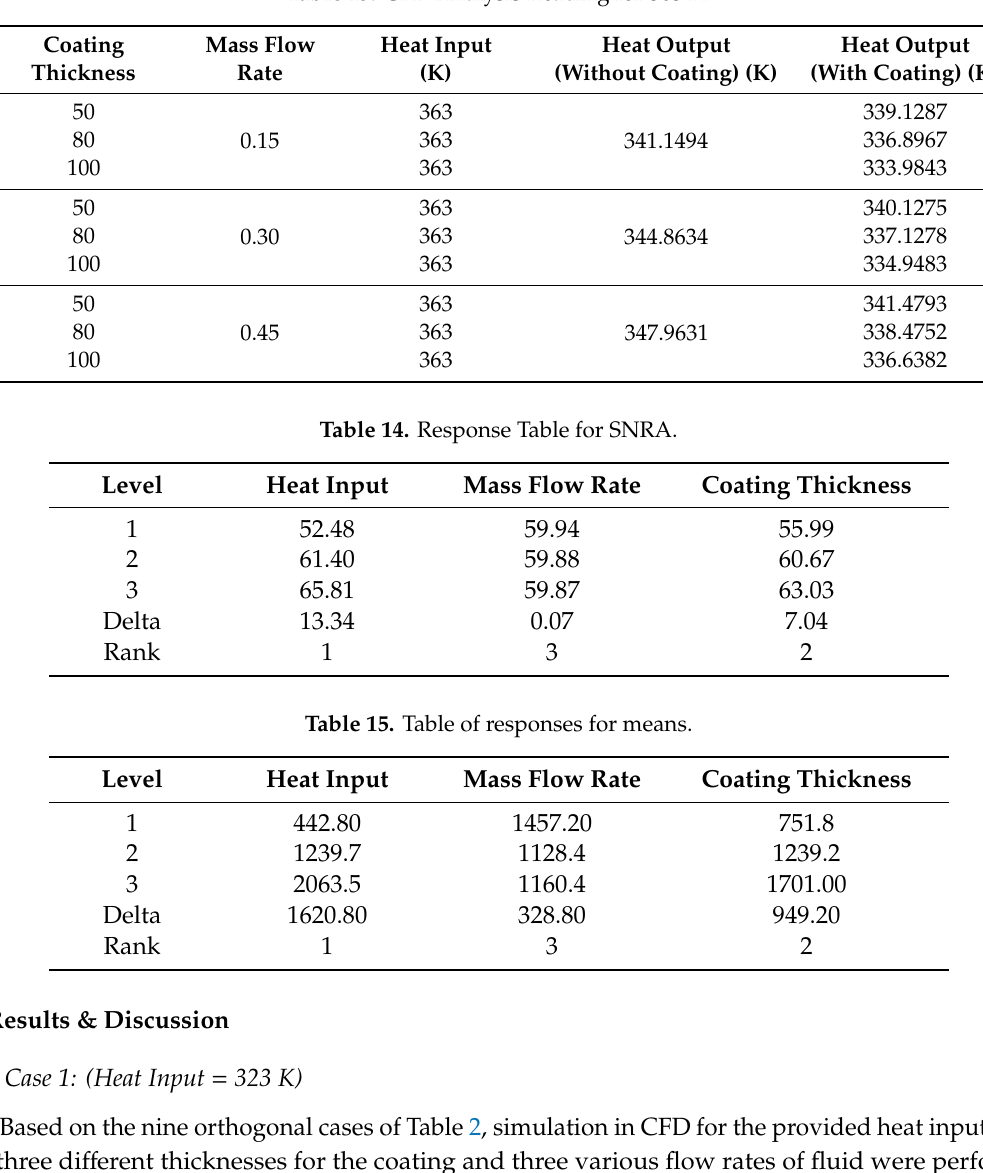
Table 13. CFD Analysis Reading for 363 K.